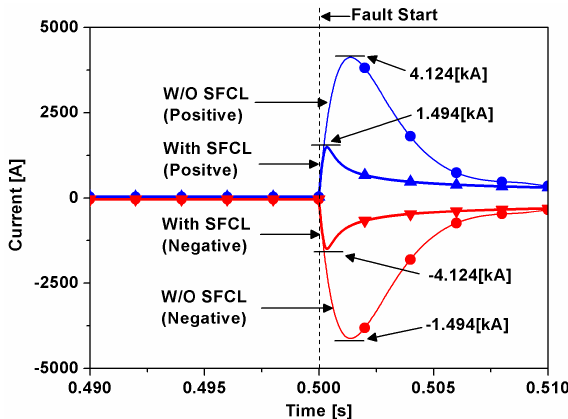
Figure 4. Fault Current according to apply or not SFCL.